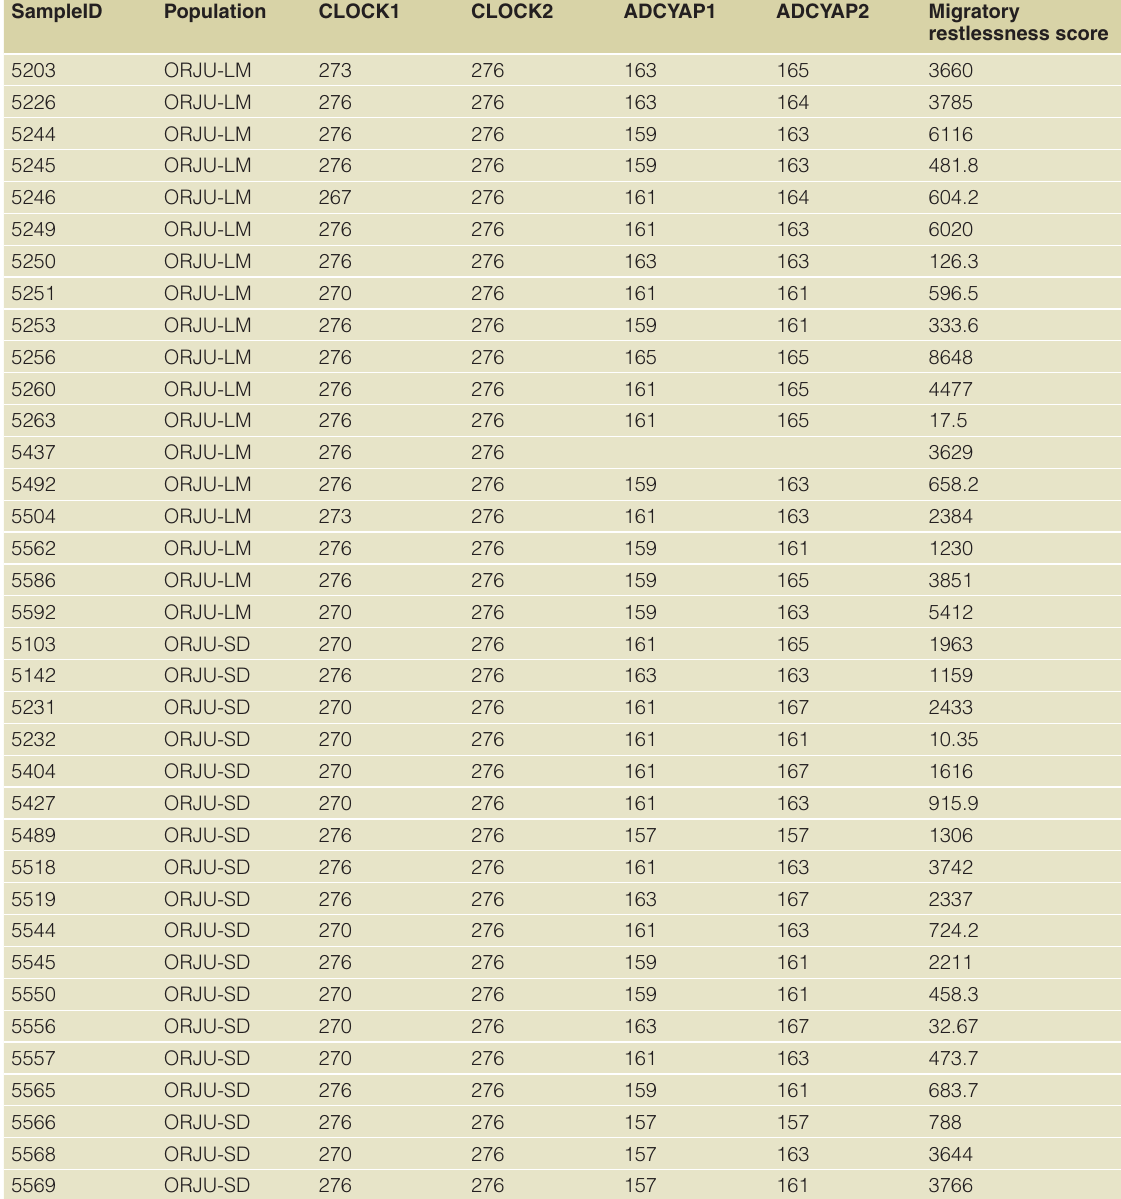
Supplementary Table 1. Individual variation in migratory restlessness and allele length. Allele calls for both CLOCK and ADCYAP1 are provided for each individual. Migratory restlessness score provides a cumulative score of migratory behavior over the sampling period (March 3 to August 1). See Methods for